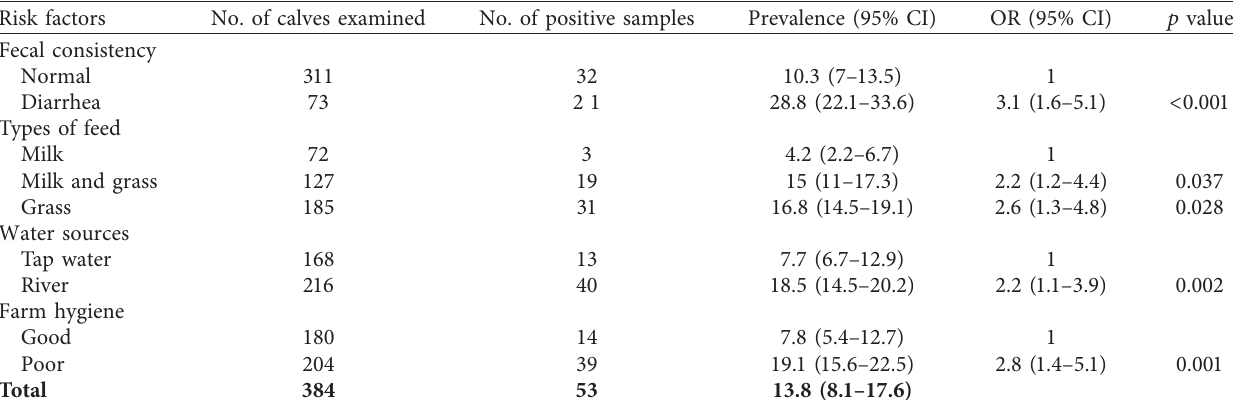
Table 3: Logistic regression analysis of fecal consistency and calf management with Cryptosporidium